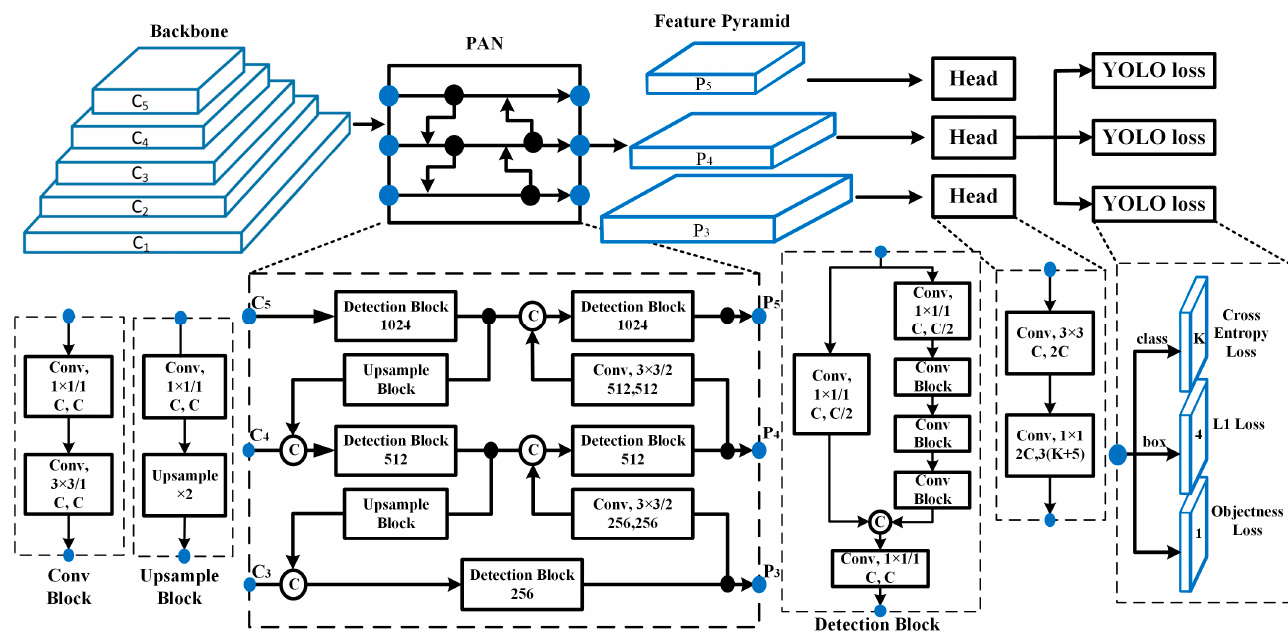
Figure 6. The framework of PP-YOLOv2.